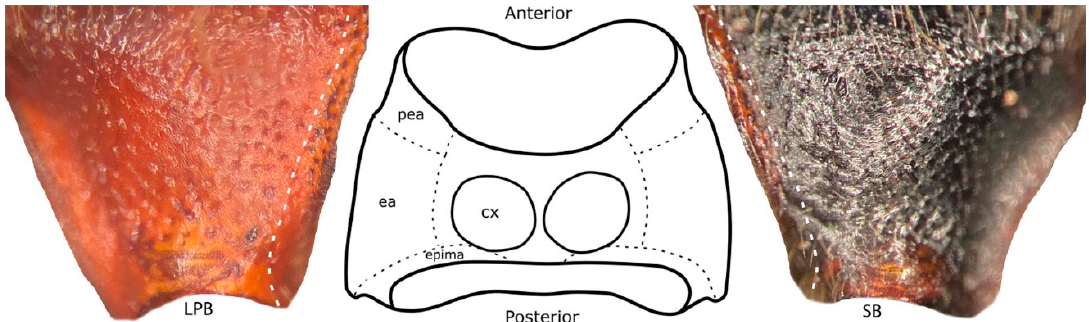
Figure 3. From anterior to posterior, the sides of a Dendroctonus thorax is divided into three areas [14]: ( 1 ), pre ‐ episternal (pea), ( 2 ) episternal (ea), and ( 3 ) epimeral (epima). The character of the relative number of punctures at the posterior half of (pea) near white dashed lines, to distinguish D. murrayanae from D. rufipennis is difficult to use. Pictures by J. Mercado, thorax line drawing adapted from Hopkins [14].